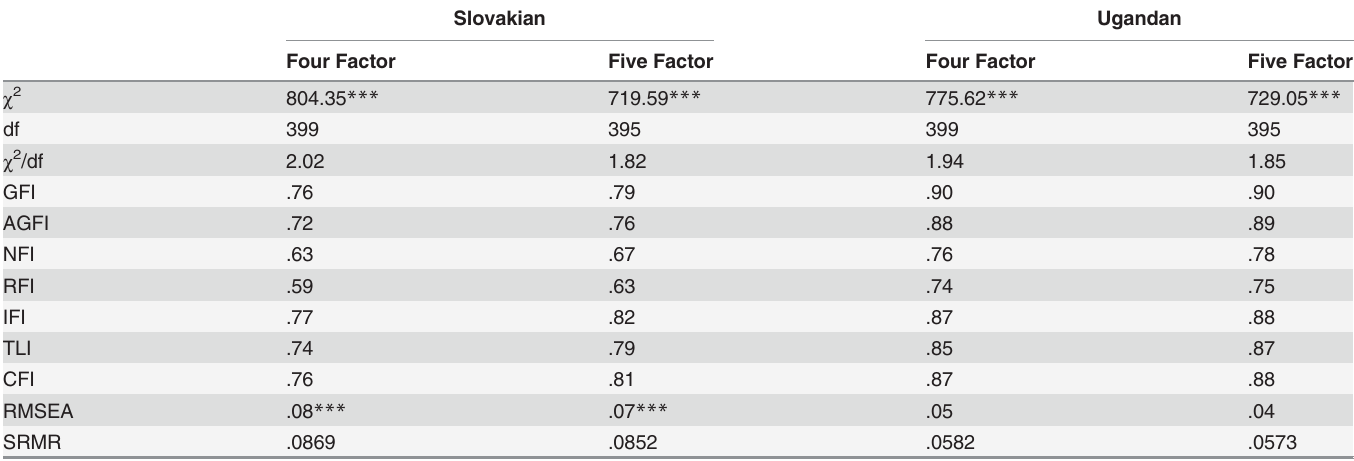
Table 14. Goodness of Fit Statistics for Con fi rmatory Factor Analysis Results for Fully Correlated Four and Five Factor Models for the ESI-R for Slovakian and Ugandan Samples. Slovakian